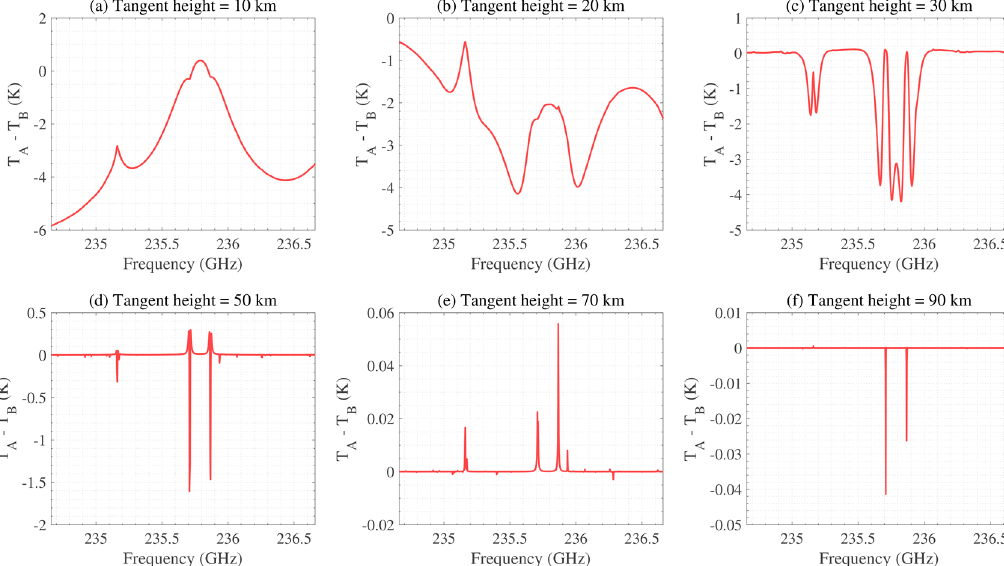
Figure 14. The brightness temperature difference T A − T B at various tangent height measured by 240 GHz radiometer (235 GHz spectrometer): ( a ) 10 km; ( b ) 20 km; ( c ) 30 km; ( d ) 50 km; ( e ) 70 km; ( f ) 90 km.